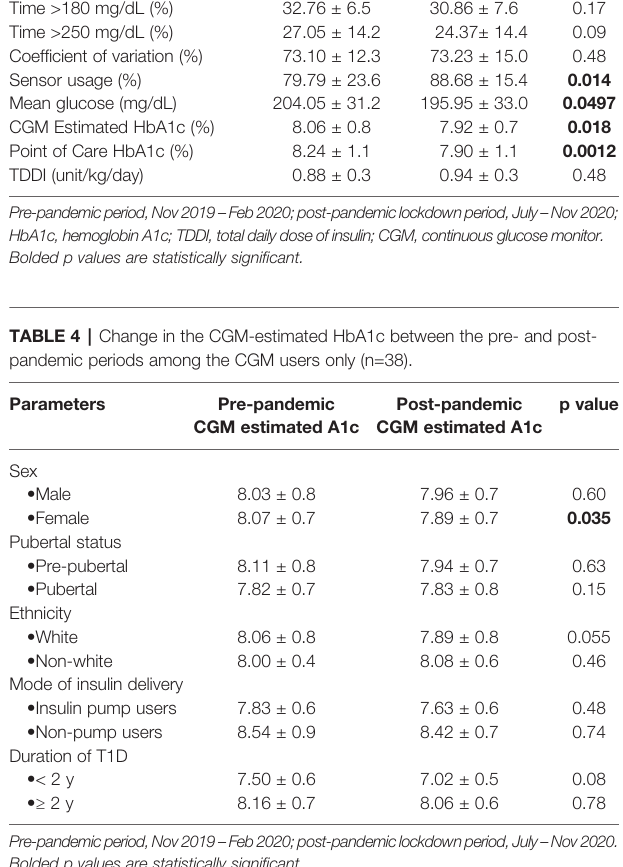
TABLE 2 | Differences in the change in point-of-care A1c between the pre- and post-pandemic lockdown periods for all subjects.